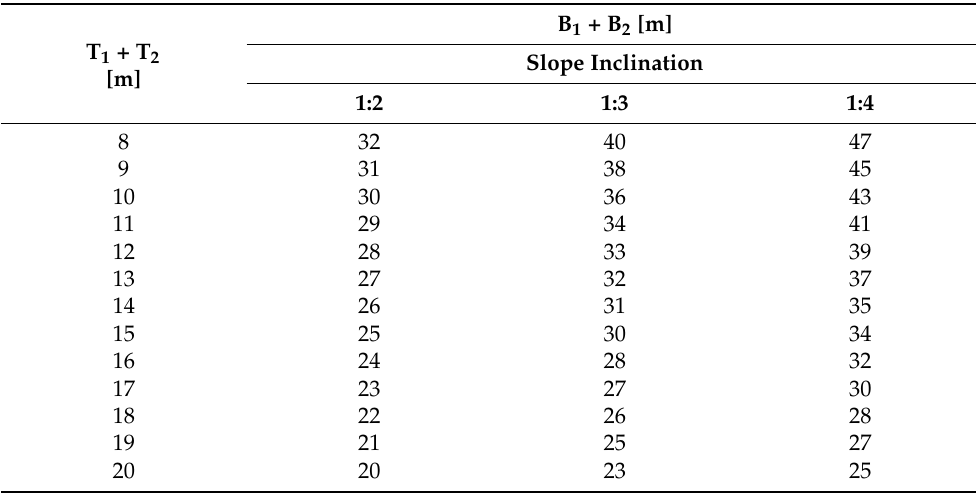
Table 2. Determination of safe breadths of passing ships in straight sections of the ´Swinouj´scie– Szczecin